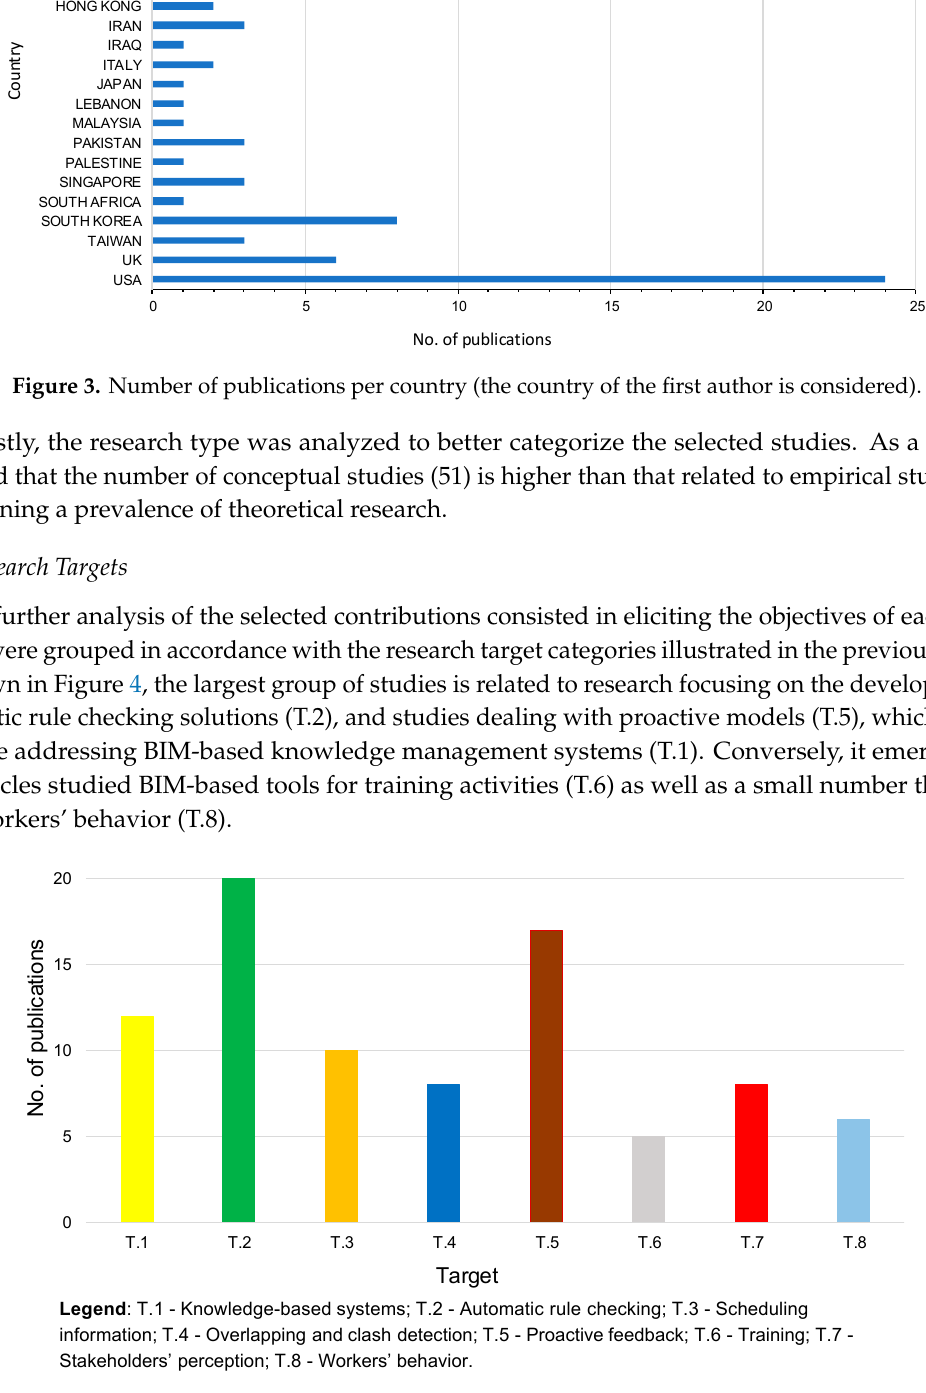
Figure 4. Number of publications per research target.